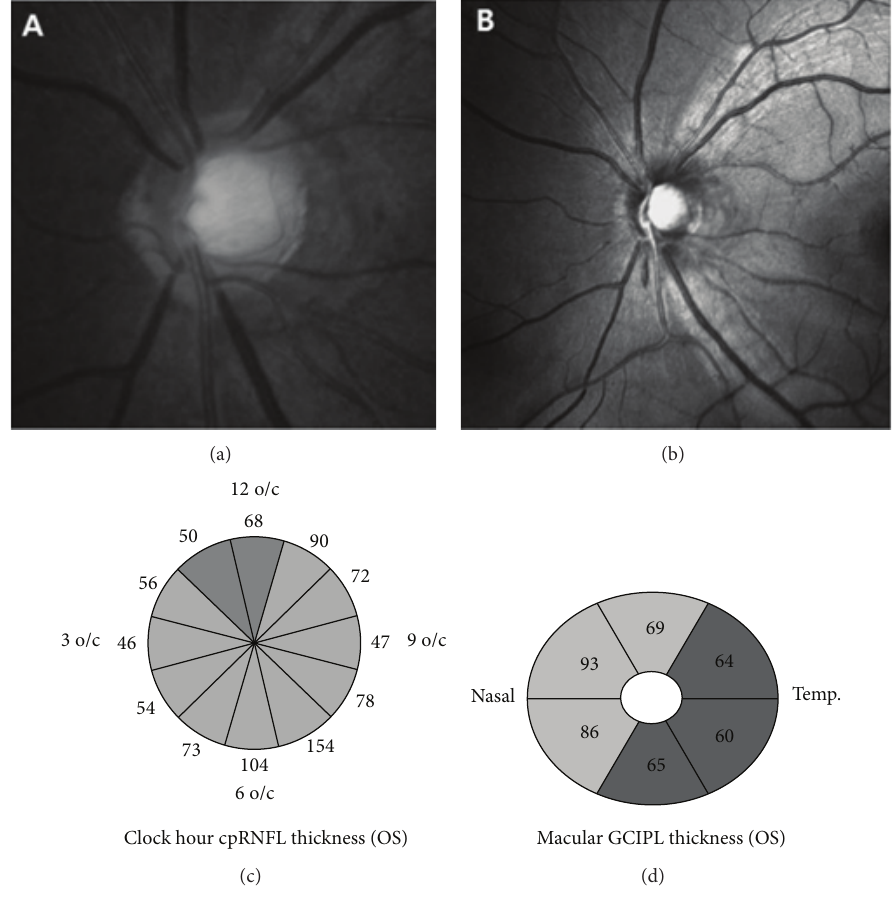
Figure 1: An example of an eye with superior segmental optic hypoplasia (SSOH) in 45-year-old female patient. (a, b) Color fundus photograph and red-free retinal nerve fiber layer (RNFL) photograph of the left eye show optic disc rim thinning and RNFL defect in the superior and superonasal segments. (c) Optical coherence tomography (OCT) shows definite thinning of RNFL in the superior and superonasal segments. (d) Macular analysis in OCT shows generalized thinning of ganglion cell inner plexiform layer (GCIPL) except superonasal and inferonasal sectors. Table 1: Demographics and ocular